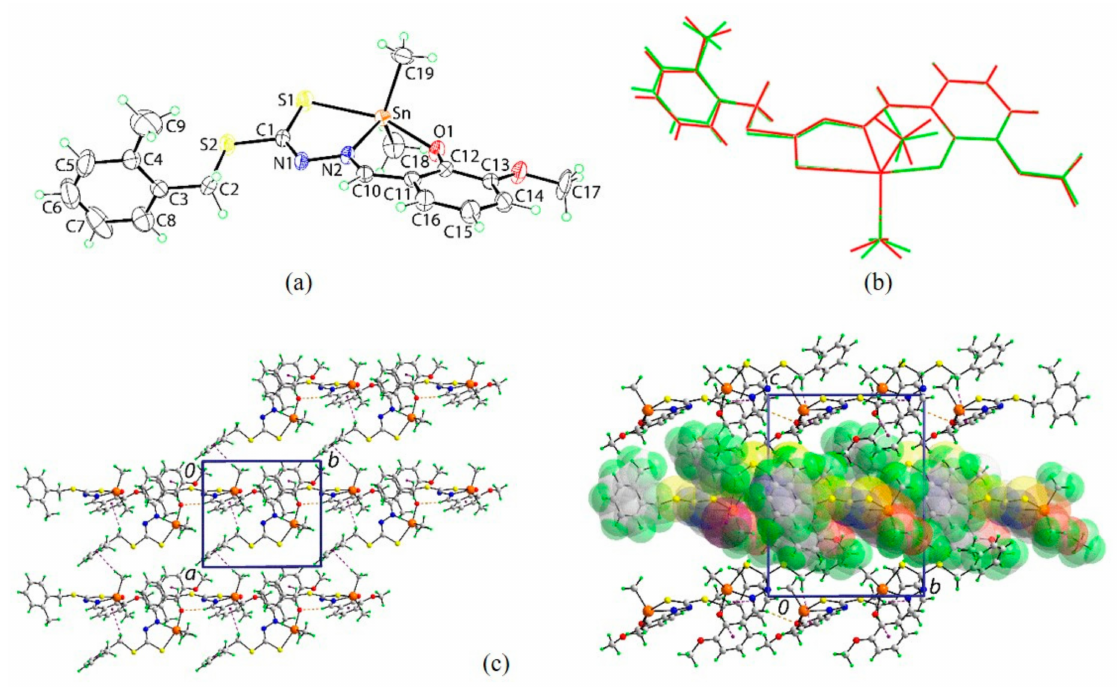
Figure 3. Crystallographic diagrams for Me 2 Sn(S2MoVa): ( a ) Molecular structure of the second independent molecule, molecule b, ( b ) overlay diagram of molecules a (red image) and inverted-b (green) drawn so the SnC 2 atoms of the Me 2 Sn moiety are overlapped and ( c ) a view of the supramolecular layer in the ab -plane (left image) and a view of the unit cell contents in projection down the a-axis with one layer highlighted in space-filling mode (right image). The C–H ... O and C–H ... π interactions are shown as orange and purple dashed lines,